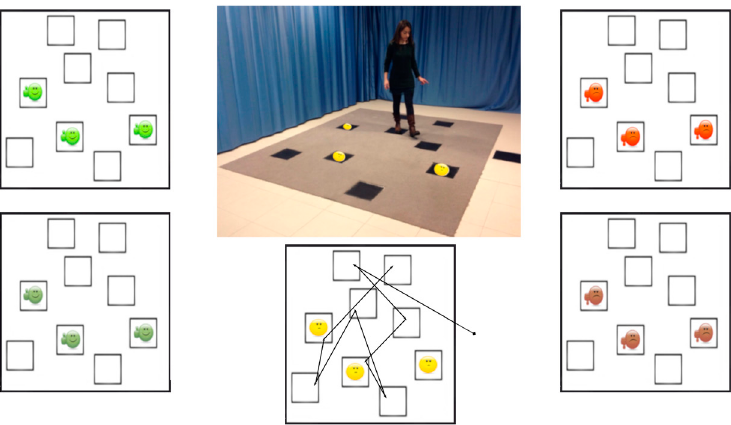
Figure 1. The landmark-based navigational memory task (the Walking Corsi Test with emotional landmarks). The eight-square path was designed in order to let participants move through the squares, as showed by the red line. In the centre of the figure is displayed the experimental set-up with a participant who performed the learning path task. Written informed consent was obtained